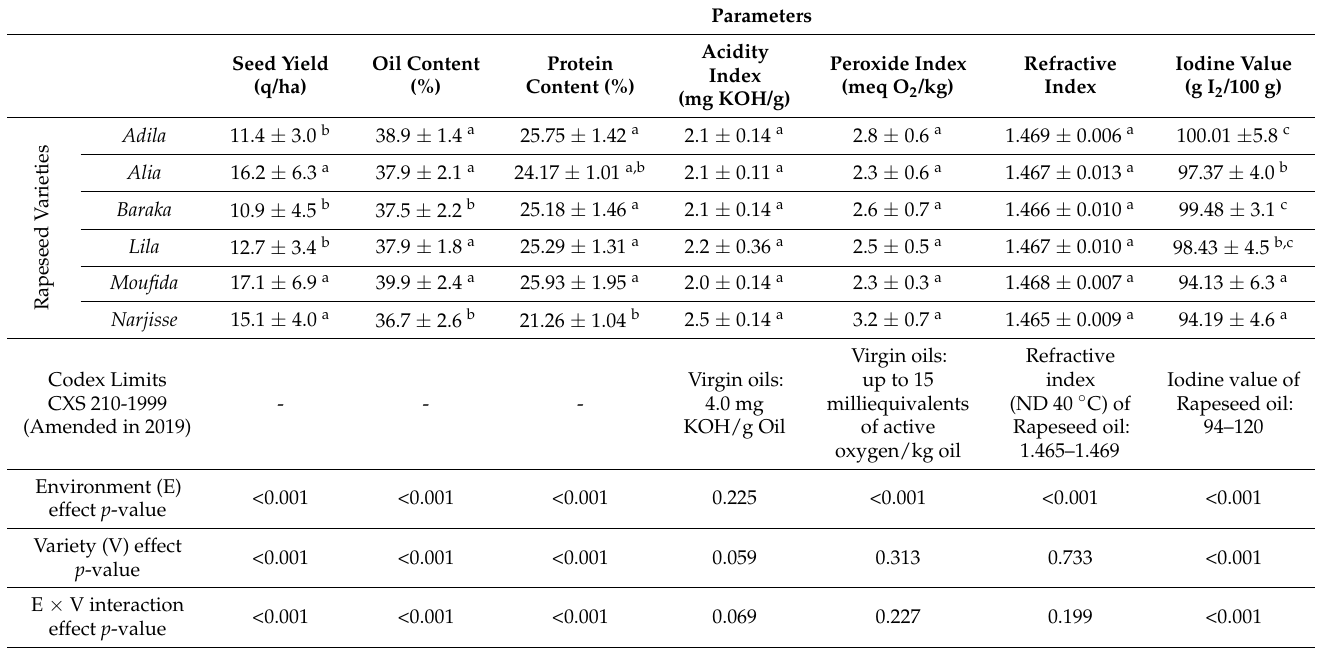
Table 2. Variation in seed yield, oil content, and other physicochemical parameters in six Moroccan rapeseed varieties evaluated in two contrasting